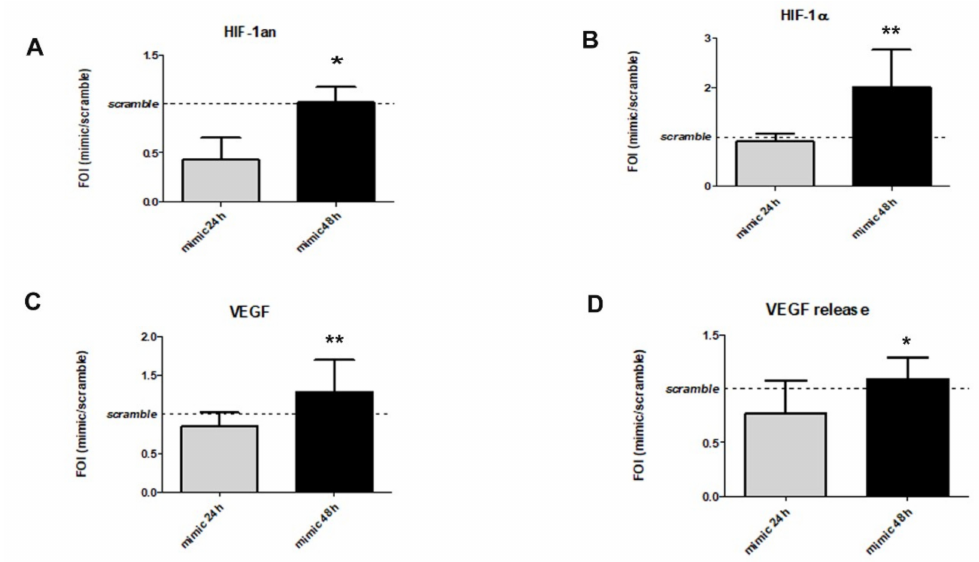
Figure 4. Study of HIF-1 α signaling as a possible target of miR-31-5p overexpression, by analysis of HIF1AN ( A ), HIF-1 α ( B ), and VEGF ( C ) gene expression and VEGF protein release ( D ). Quantitative RT-PCR data are expressed as fold of change (FOI) in gene expression (2 − ∆∆ C t ) occurred in Mimic vs. Scramble groups. ELISA data are expressed as ABS values at 450 nm or in terms of FOI compared to hMSCs transfected with mimic and scramble group. No differences were found between mimic and scramble groups or between experimental time for HIF-1 α nuclear levels. Student’s t test: *, p < 0.05: **, p < 0.005 between experimental